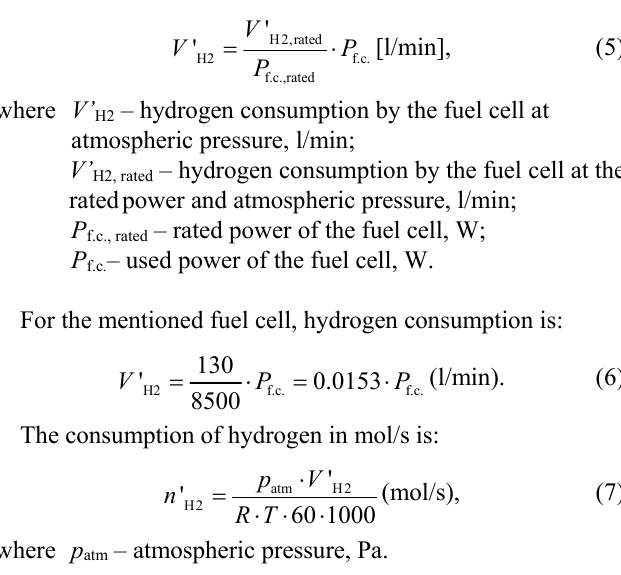
Fig. 5. The voltage/load characteristics of the alternative energetics microgrid: V d – DC bus voltage; V d,r – DC bus rated